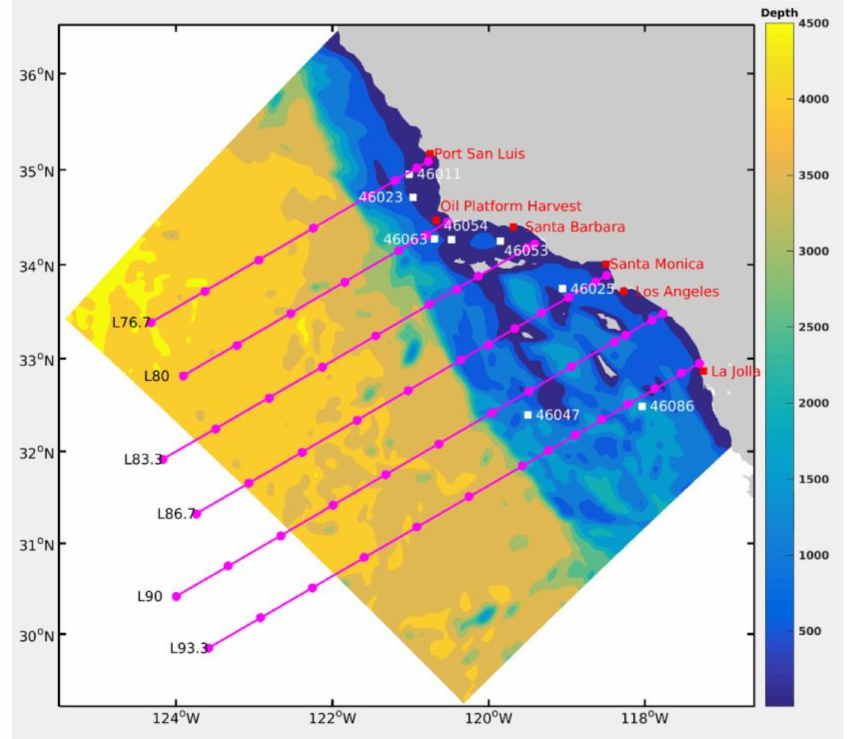
Figure 8. ROMS model domain and bathymetry. The color shadings show the bathymetry (units: m). Pink lines are the California Cooperative Oceanic Fisheries Investigations cruise lines with dots showing stations and line numbers marked on the western ends. White squares denote the National Buoy Data Center buoy stations. Red squares represent six tidal gauges, including the station ID (from